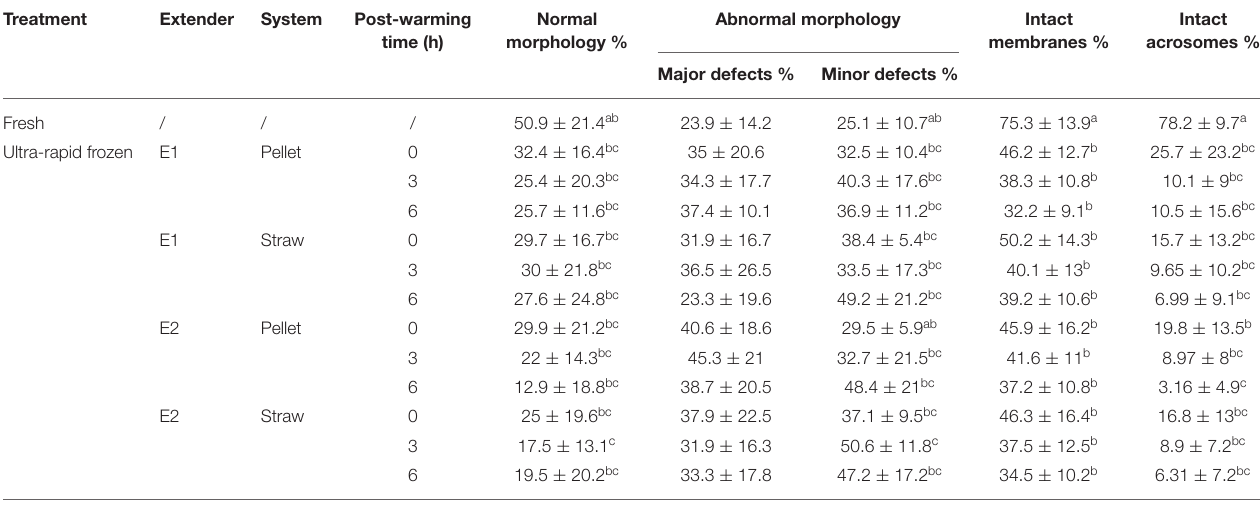
a , b , c Different superscripts indicate significant differences within columns (p ≤ 0.05).